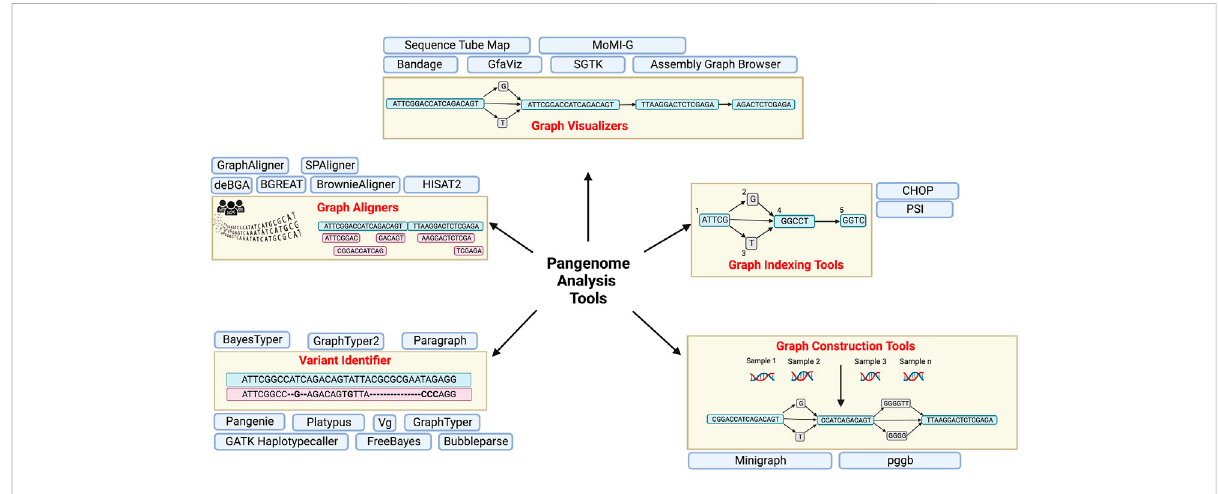
FIGURE 3 Pangenome applications and pipelines with brief description. Created with